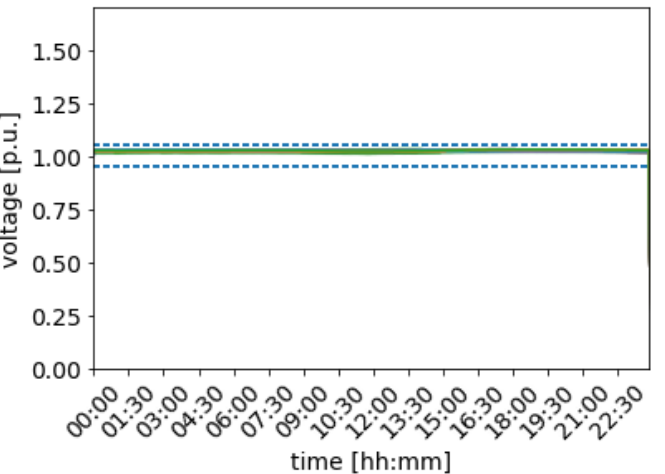
Figure 11. Scenario 1 distribution feeder nodal voltage means and 95% range for all nodes plotted by substation feeder group .